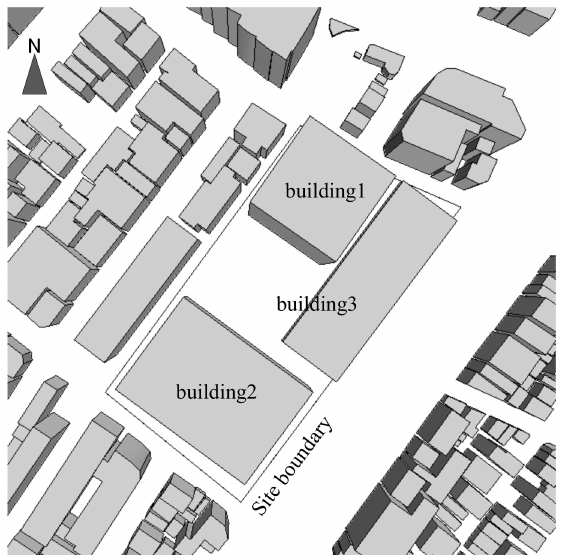
Figure 3. Initial building